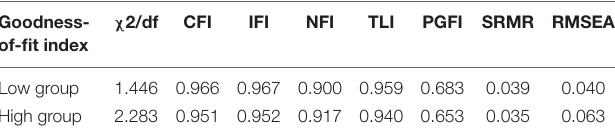
TABLE 5 | Goodness-of-fit test.